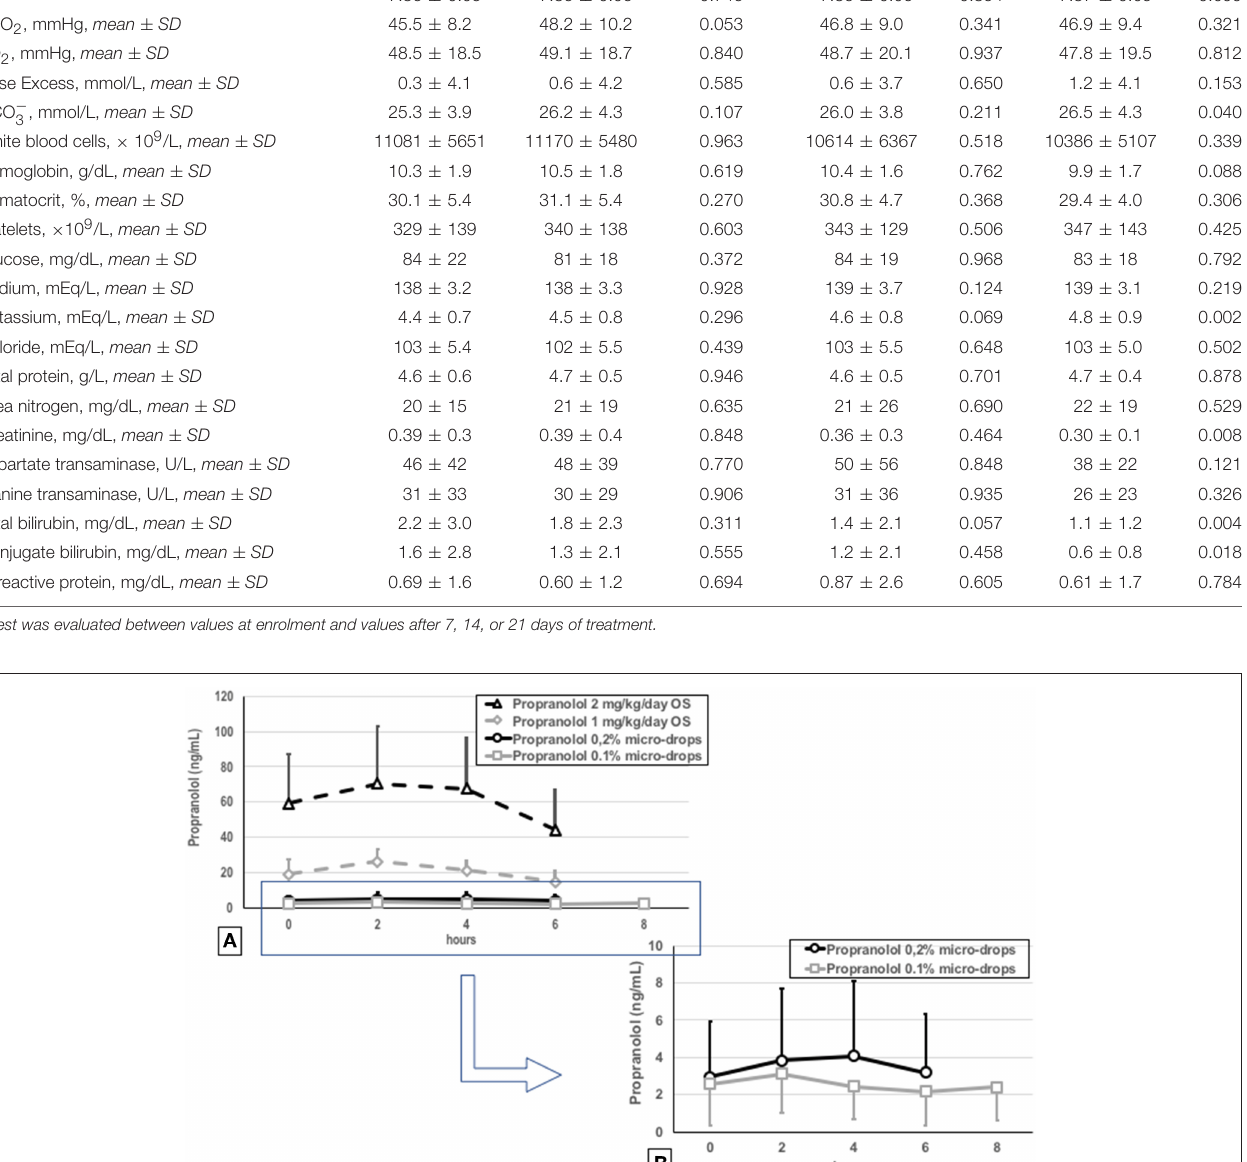
died from suspected viral sepsis 69 days after the discontinuation of propranolol treatment. A third infant, suffering from multiple thromboembolism, died because of renal failure after 24